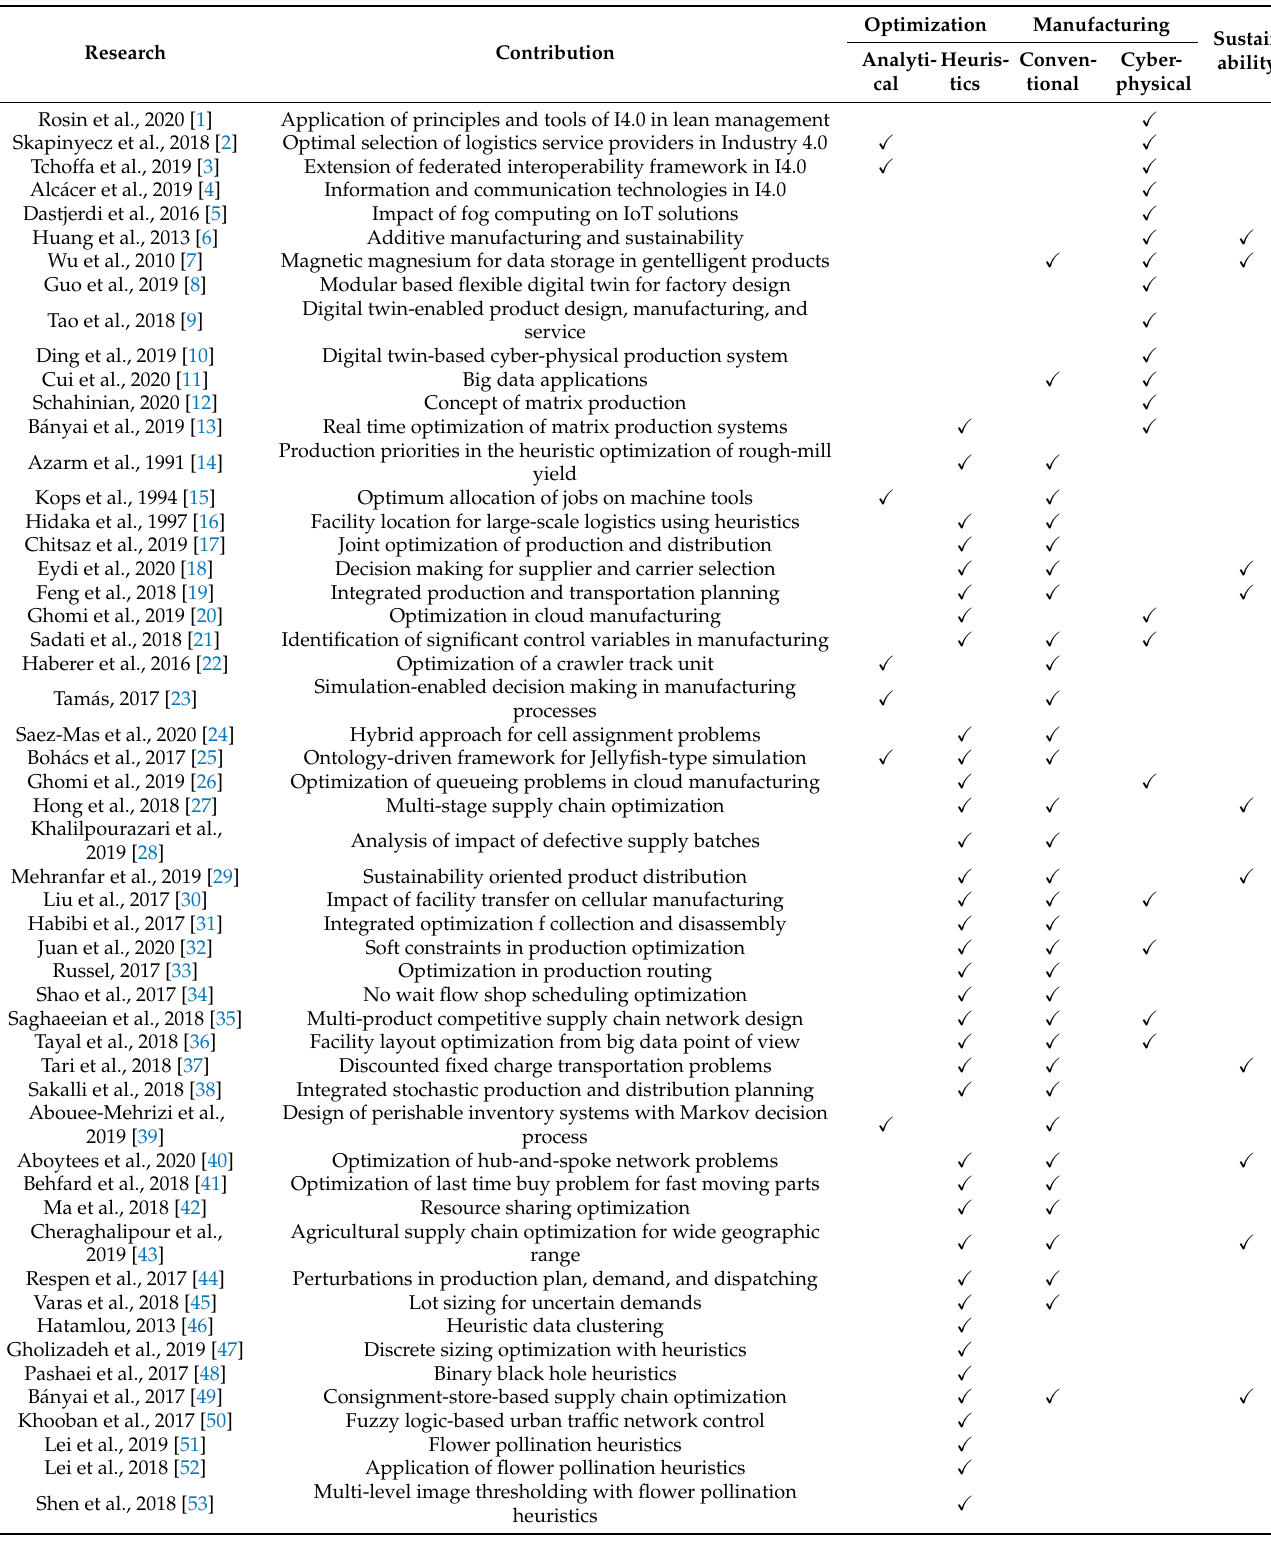
Table 1. Authors’ contributions related to the optimization of cyber-physical production systems including I4.0 and heuristic optimization